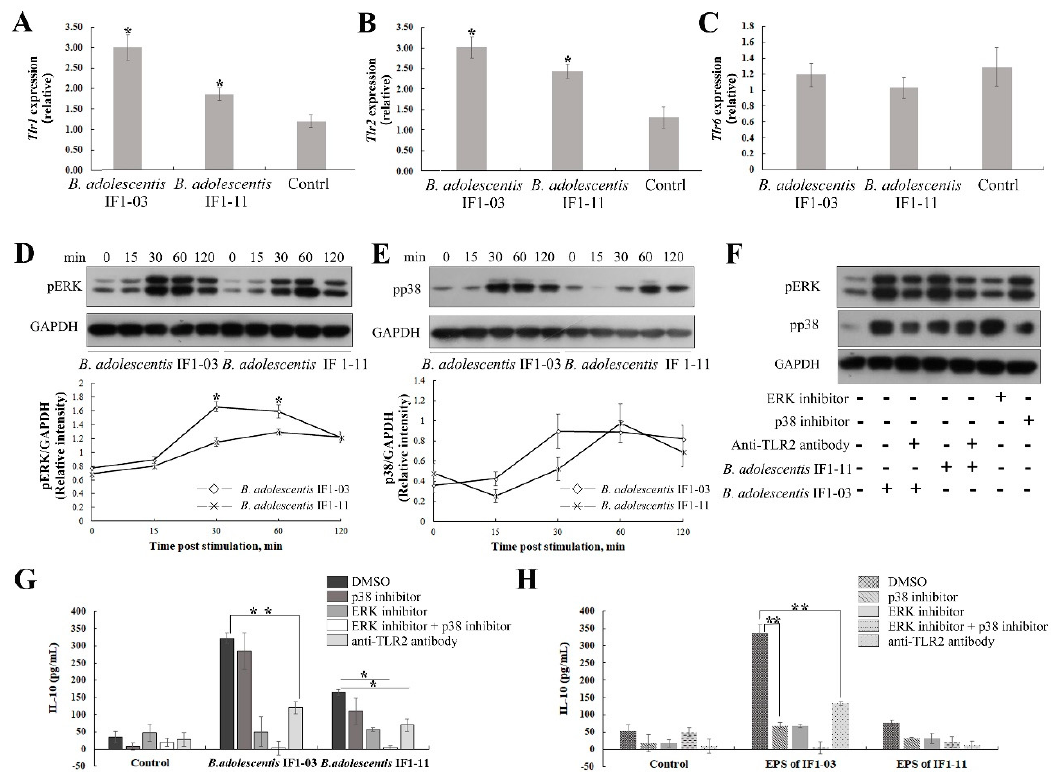
Figure 5. Activation of TLR2 and subsequent ERK/p38- MAPK signaling in RAW264.7 macrophages after stimulation with two bifidobacterial strains. Total RNA of macrophages stimulated with B. adolescentis IF1-11 and B. adolescentis IF1-03, and control macrophages, was isolated at 4 h for cDNA synthesis and assay. Expression of Tlr1 ( A ), Tlr2 ( B ) and Tlr6 ( C ) was analyzed by qRT-PCR. Western blot analysis of the phosphorylated ERK (pERK) ( D ) and phosphorylated p38 (pp38) ( E ) in treated macrophages at the indicated times. Western blot analysis of pERK and pp38 of B. adolescentis IF1-03 and IF1-11-stimulated macrophages in the presence of anti-mouse TLR2 antibody, and ERK/p38-MAPK signal pathway inhibitors ( F ). IL-10 synthesis and secretion in macrophages stimulated with B. adolescentis IF1-11 and IF1-03 strains, in the presence of anti-mouse TLR2 antibody and specific chemical inhibitors of ERK (PD98059, 10 µ M) and p38 (SB203580, 10 µ M) phosphorylation ( G ). EPSs of different strains stimulate IL-10 production of macrophages in the presence of TLR2 antibody and inhibitors, respectively. IL-10 concentration in supernatants of cell cultures was determined by ELISA ( H ). Data are shown as mean ± SD for three independent experiments, statistically significant difference is indicated (* p < 0.05, ** p < 0.01).